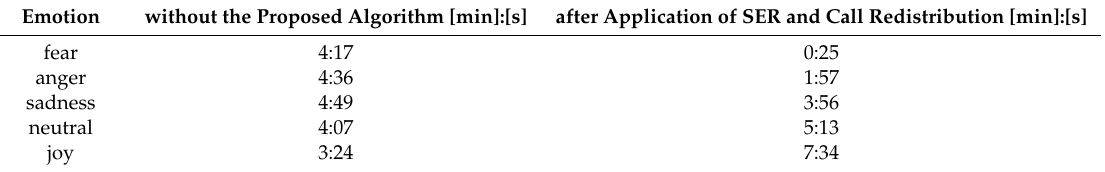
Table 3. Average waiting time when 5 calls are received simultaneously while all operators are